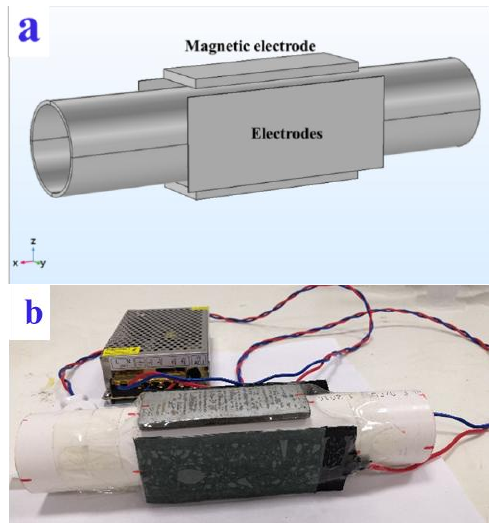
Fig. 4. Diagram of the treatment device by electromagnetic compound field (a: diagram; b: